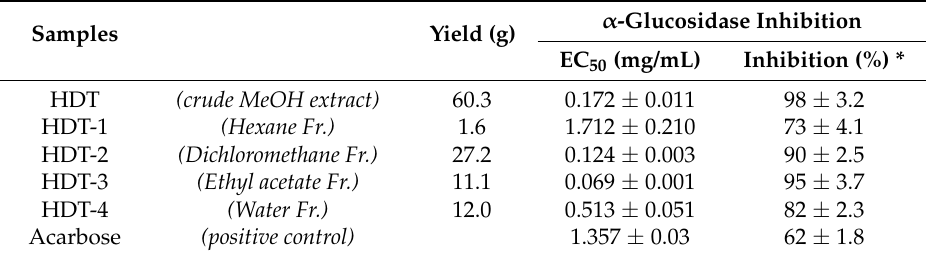
Table 2. α -glucosidase inhibition of HDT and its fractions after